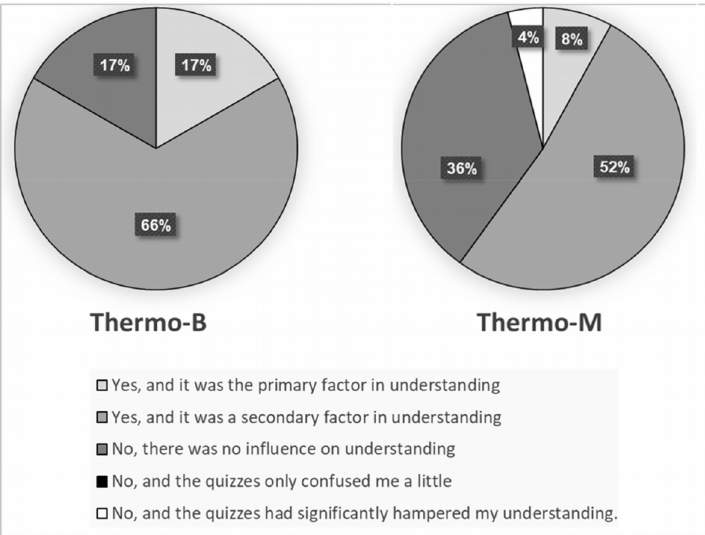
Figure 2. Students’ perceptions of the Kahoot! contribution to course content